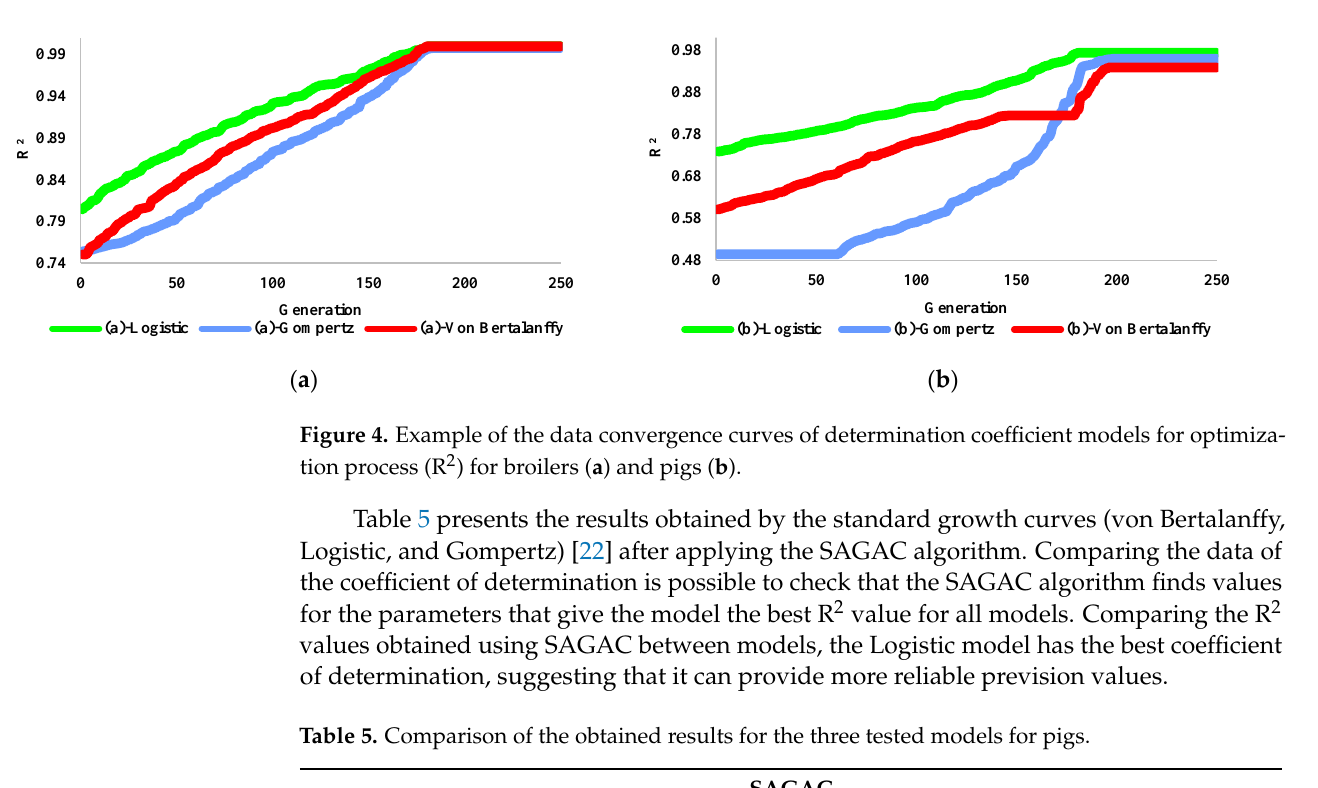
Table 6. Comparison of the obtained results for the three tested models for the broilers.